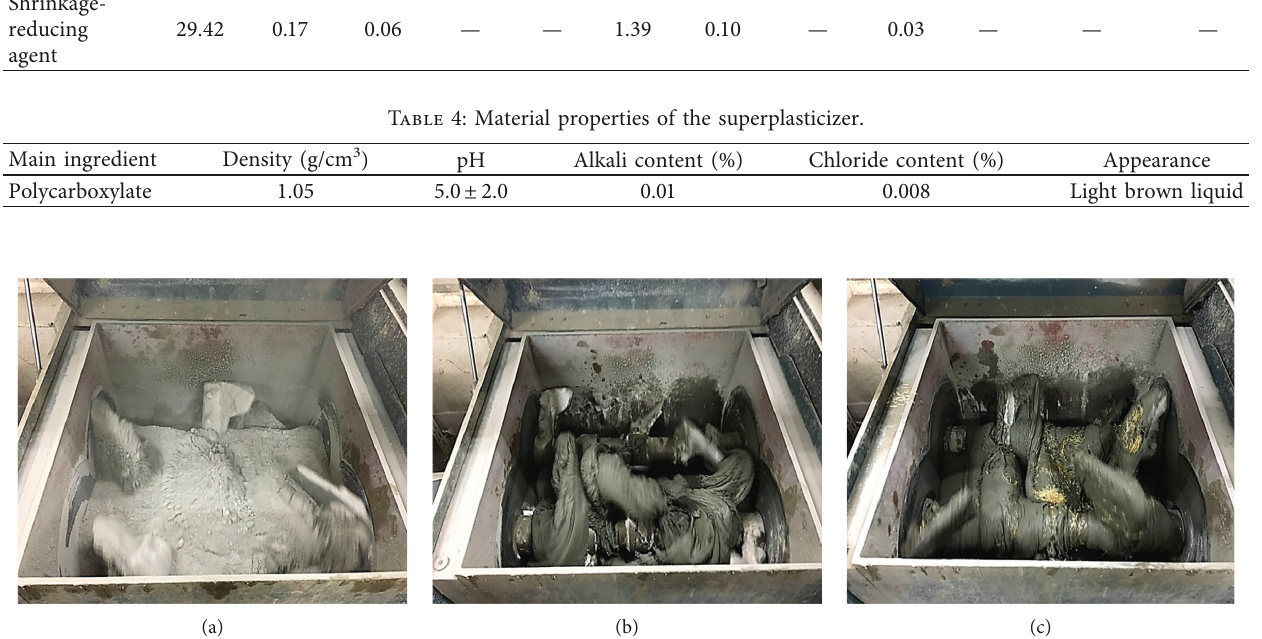
Figure 3: Mixing process of UHPC: (a) dry mixing (mixing:10 minutes), (b) adding water and superplasticizer (mixing: 6 minutes), and (c) putting steel fibers (mixing: 4